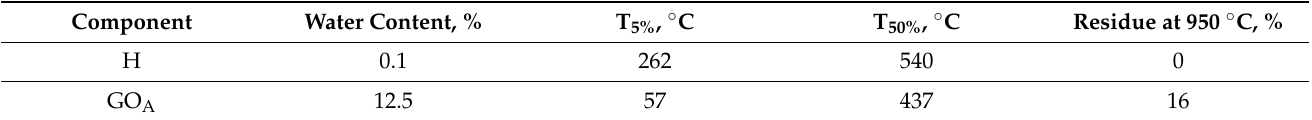
Figure 3. TG and DTG curves of H ( a ) and GO A ( b ) in air. Table 3. The thermo-oxidative properties of H and GO A